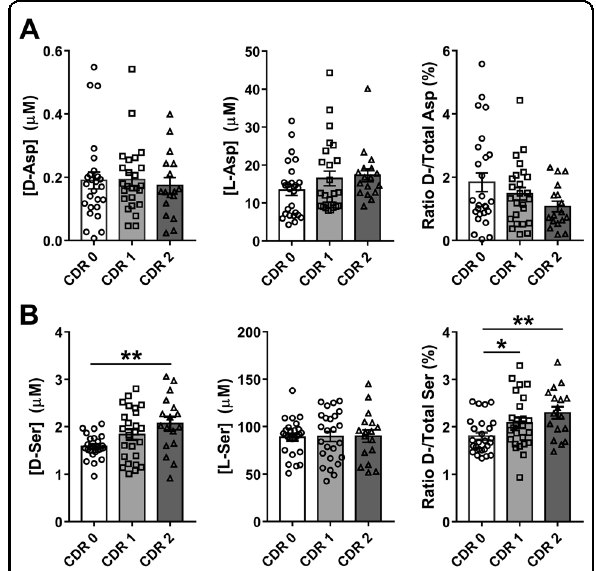
Fig. 3 Variations of aspartate and serine enantiomer levels in serum of healthy subjects and AD patients at different stages of the disease. D - and L -Asp ( A left and center, respectively) and D - and L - Ser ( B left and center, respectively) levels and ratio between D - enantiomer and total ( D + L ) amino acid content ( A right and B right for Asp and Ser, respectively, expressed as percentage) detected in serum samples of AD patients compared to healthy subjects (CDR 0) related to the stage of the pathology. Dots and bars represent the single subjects ’ values and the standard error of the mean, respectively. * P < 0.05; ** P < 0.01 (Mann – Whitney unpaired test). Disease stage was assessed by Clinical Dementia Rating (CDR) score (see Materials and methods): CDR 0: healthy subjects; CDR 1: mild dementia; CDR 2: moderate